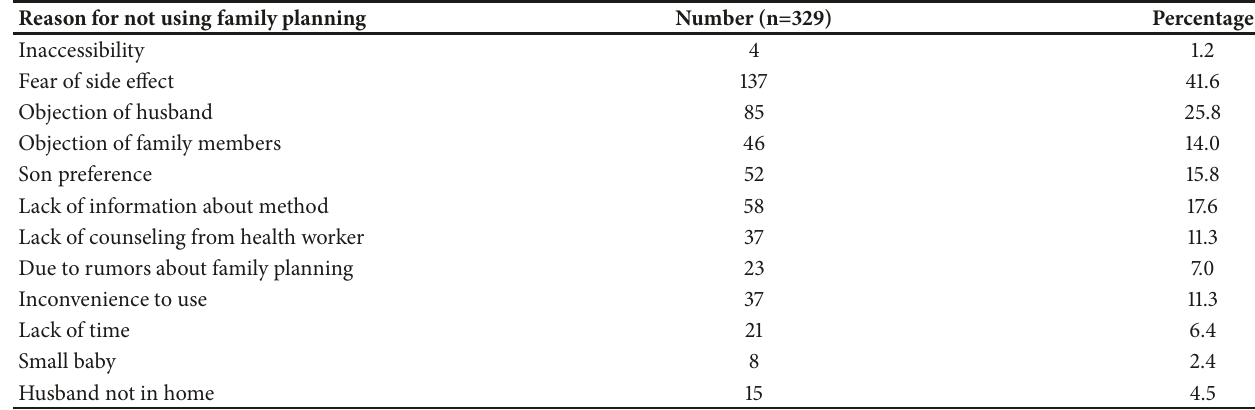
Table 3: Distribution of common reasons for not using family planning methods of study